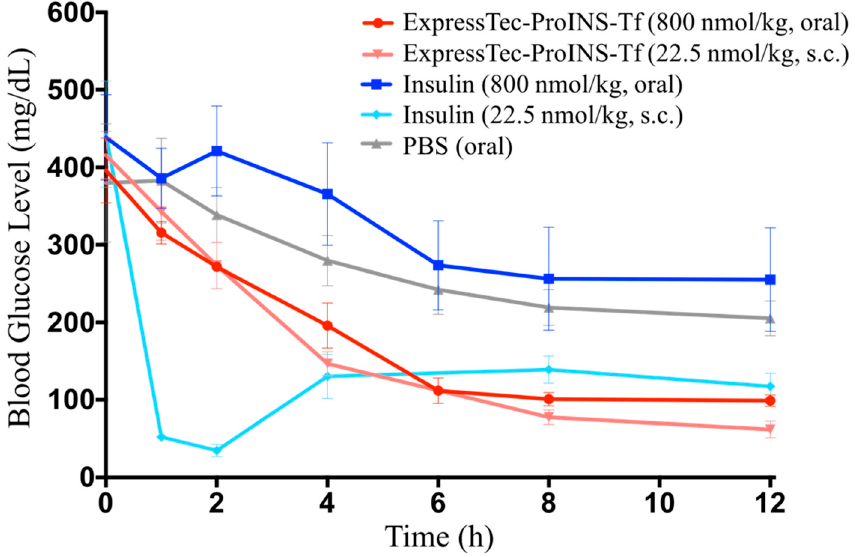
Figure 7. Glucose-lowering effect of ExpressTec-ProINS-Tf via oral administration. STZ-induced type 1 diabetic mice were fasted for 3 h before the oral or subcutaneous (s.c.) administration of protein at the indicated doses or PBS ( n ≥ 3 per group). Mice were kept fasted with free access to water until 12 h post injection. Blood glucose levels were monitored at the indicated time points.